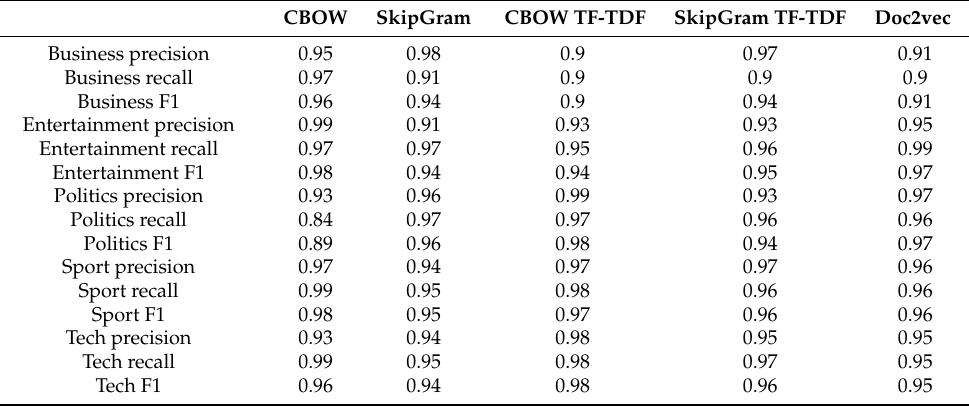
Table 5. Precision, recall, and F1 scores for all vectorization methods with Naive Bayesian Classifier classification by specific topics.